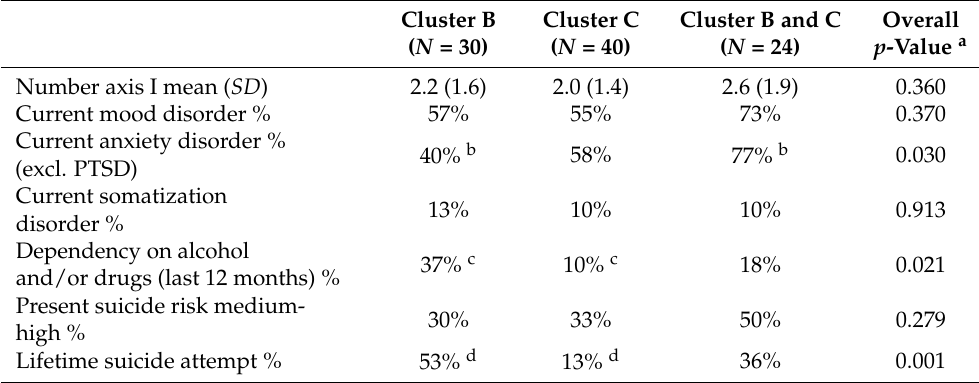
Table 2. Comparison of comorbidity and suicidality variables between cluster B, cluster C and cluster B and C PDs ( N = 94).